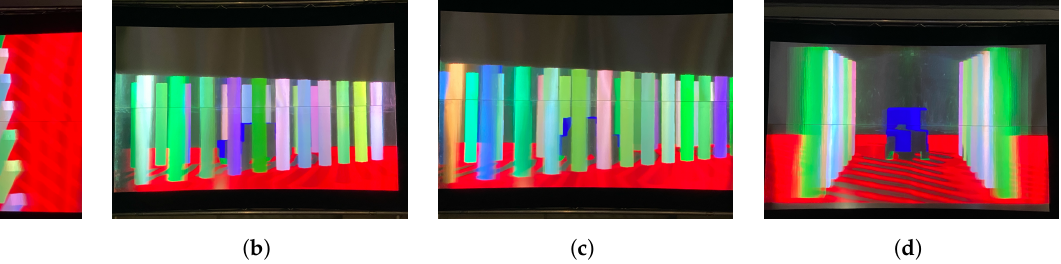
Figure 4. Orthographic views. ( a ) Top view. ( b ) Right side view. ( c ) Left side view. ( d ) Front view.